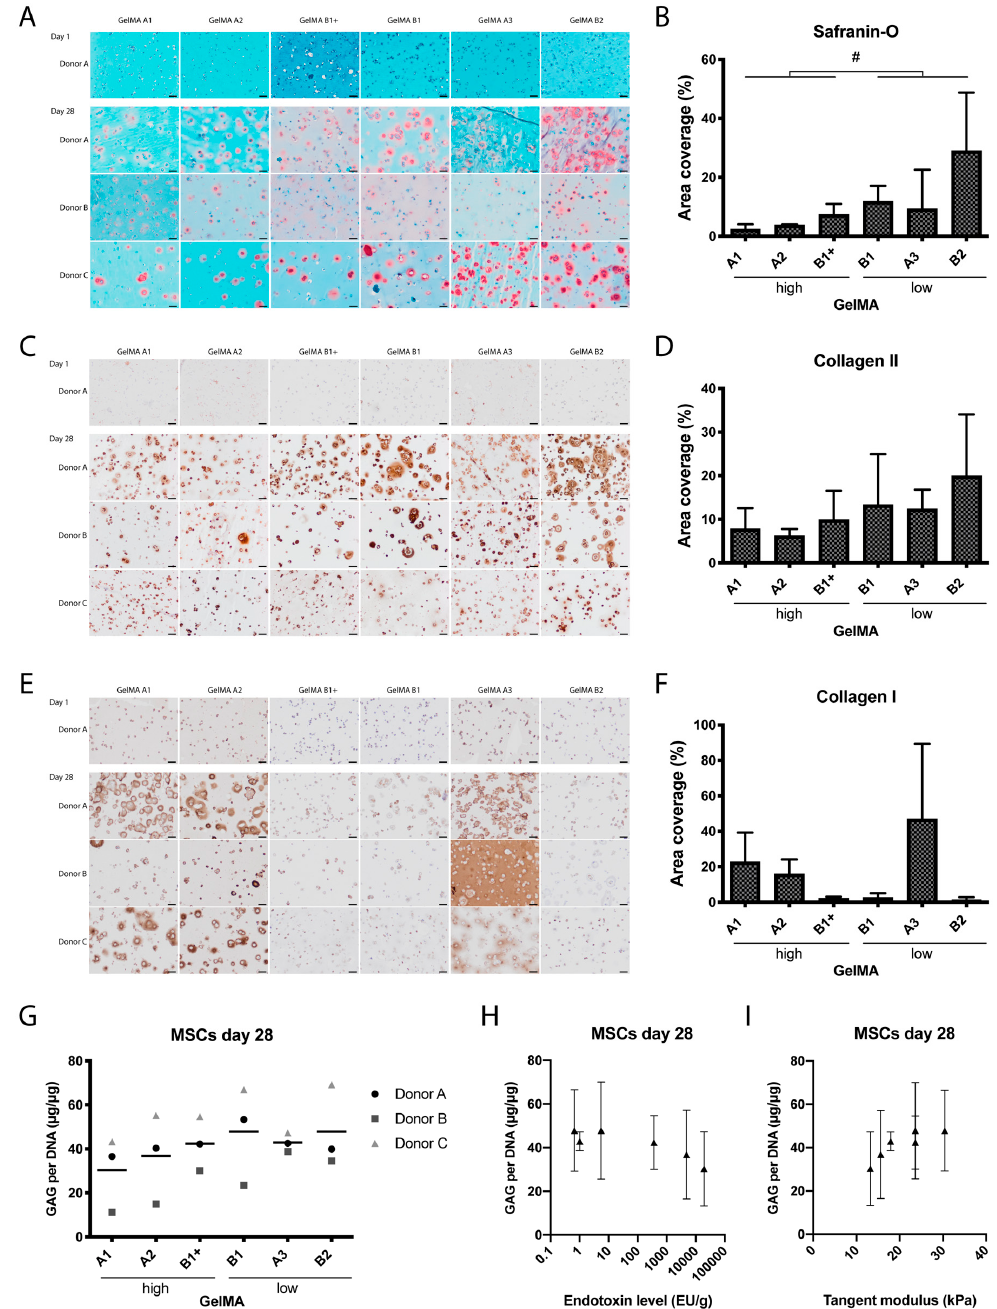
Figure 2. Cartilage-like matrix formation by equine MSCs after 28 days of culture in six hydrogels from five di ff erent GelMAs. GelMA B1 was supplemented with LPS to obtain high endotoxin GelMA B1 + . Baseline immunohistochemical stainings are shown for donor A on day one and for all donors on day 28. Safranin-O / Fast Green stains collagen, bone or cytoplasm green and GAGs red / pink ( A ). Immunohistochemical staining for collagen type II ( C ) and collagen type I ( E ) in brown; nuclei are stained blue. Scale bars represent 50 µ m. Semi-quantitative analysis of the total surface of pink stained areas in the safranin-O staining ( B ) and of brown stained areas in the collagen type II ( D ) and collagen type I ( F ) immunostainings. GAG content normalised to DNA after 28 days of chondrogenic di ff erentiation ( G ). GAG content did not correlate significantly with the endotoxin level ( H ) or the compressive tangent modulus ( I ). The symbols in G represent the mean of six technical replicates per donor, the line represents the mean of three donors. In ( B , D , F , H , I ) the values represent mean ± SD of three donors. #: significant di ff erence of grouped analysis ( p <